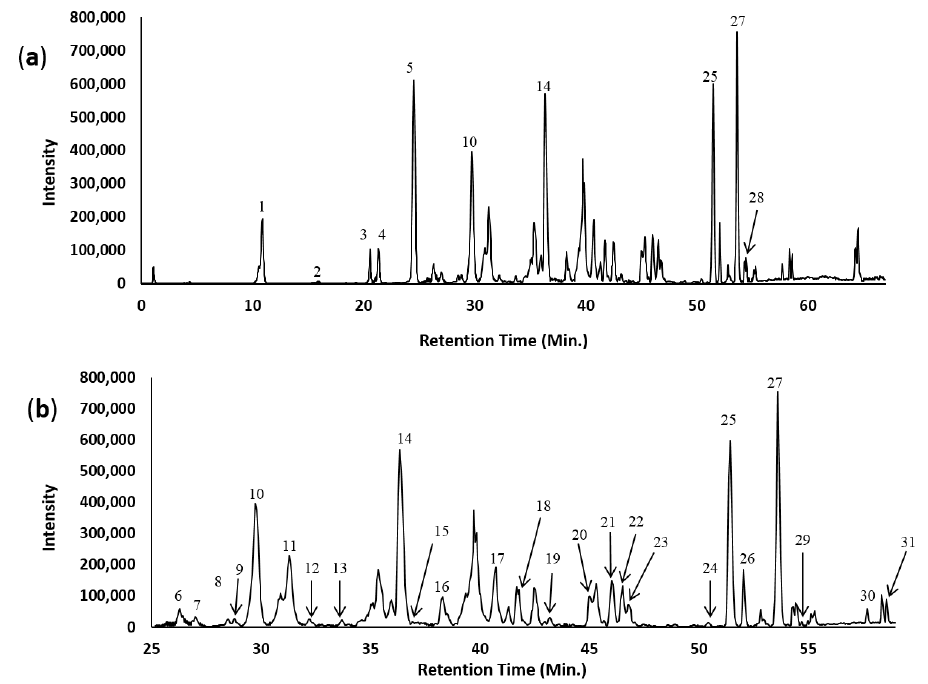
Figure 1. ( a ) Base peak chromatogram (BPC) of L. indica ethyl acetate fraction by HPLC-ESI-MS in negative ionization mode; ( b ) Expanded BPC. Peak labeling represents the compounds identified. Table 1. Identification of compounds from ethyl acetate fraction of L. indica by HPLC-ESI-microTOF- Q-MS/MS at 254 nm in negative ionization mode.